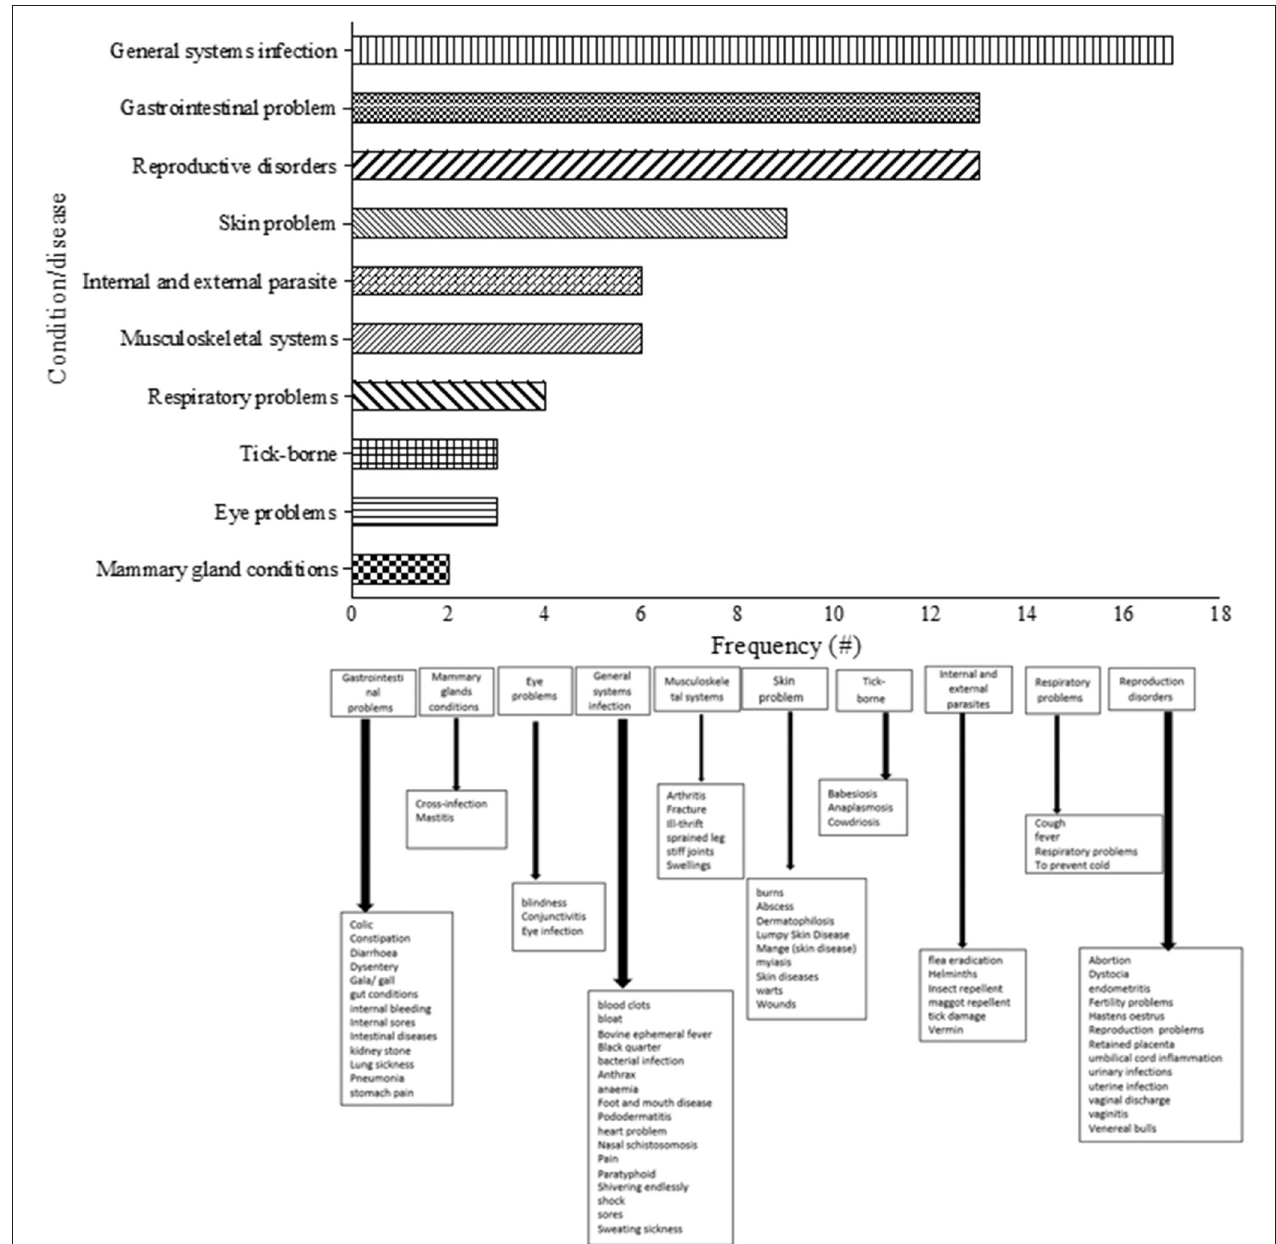
FIGURE 6 | An overview of common cattle ailments treated with medicinal plants in South Africa.